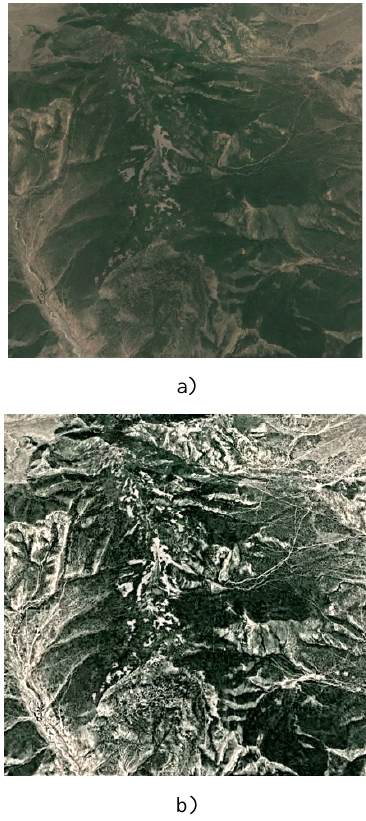
Fig. 7 . Enhancement results for the Image #4.